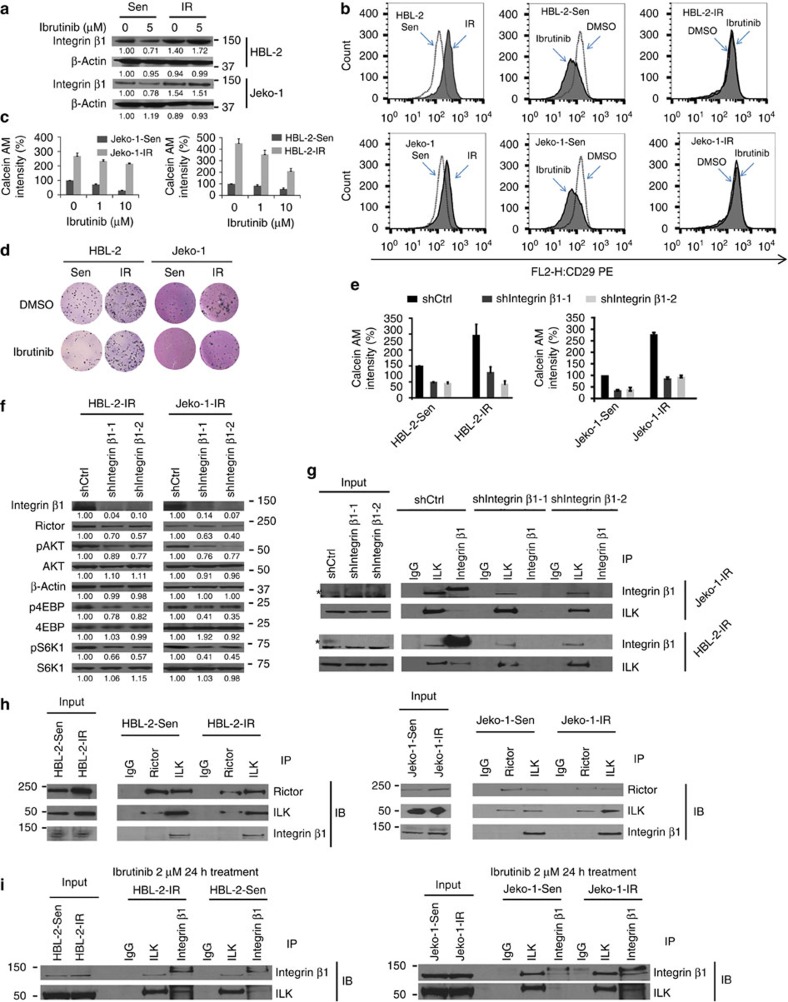
Interplay of PI3K-AKT-mTORC and integrin β1/integrin linked kinase pathways in IR MCL cells.(a,b) Western blots (a) and flow cytometry (b) showing increased and sustained integrin β (β1) expression in IR MCL cells compared to parental (Sen) cells in the absence and presence of ibrutinib treatment (6 h). (c) Cell adhesion assay showing increased and sustained cell adhesion of IR MCL cells to stromal HK cells in the absence and presence of ibrutinib treatment (12 h). (d) Colony formation assay showing enhanced clonogenic growth in IR MCL cells in the absence and presence of ibrutinib treatment. (e,f) Cell adhesion assay (e) and western blots (f) showing stable integrin β1 (CD29) knockdown with shRNAs significantly decreased rictor, pAKT, p4EBP and pS6K1 in IR MCL cells and significantly attenuated cell adhesion of parental (Sen) and IR MCL cells to HK stromal cells. (g) Co-immunoprecipitation revealed β1 and ILK form a complex in Jeko-1-IR and HBL-2-IR cells and β1 knockdown abolished β1/ILK complex formation. *indicates the specific band for integrin β1 (h) Co-immunoprecipitation showing ILK co-immunoprecipitates with rictor to form a more abundant complex in Jeko-1-IR and HBL-2-IR cells versus that shown in their parental (Sen) cells. (i) Co-immunoprecipitation showing suppression of β1/ILK co-immunoprecipite formation in parental (Sen) but not in IR MCL cells after ibrutinib treatment in HBL-2-IR and Jeko-1-IR cells. Scale bar, 10 μm. Results in a–g are representative of at least three independent experiments or means±s.d. from at least three biological replicates. For a–f, relative changes of proteins were measured by quantitative densitometry and indicated below each lane. See also Supplementary Figs 3, 8 for full gel scan of the WB.